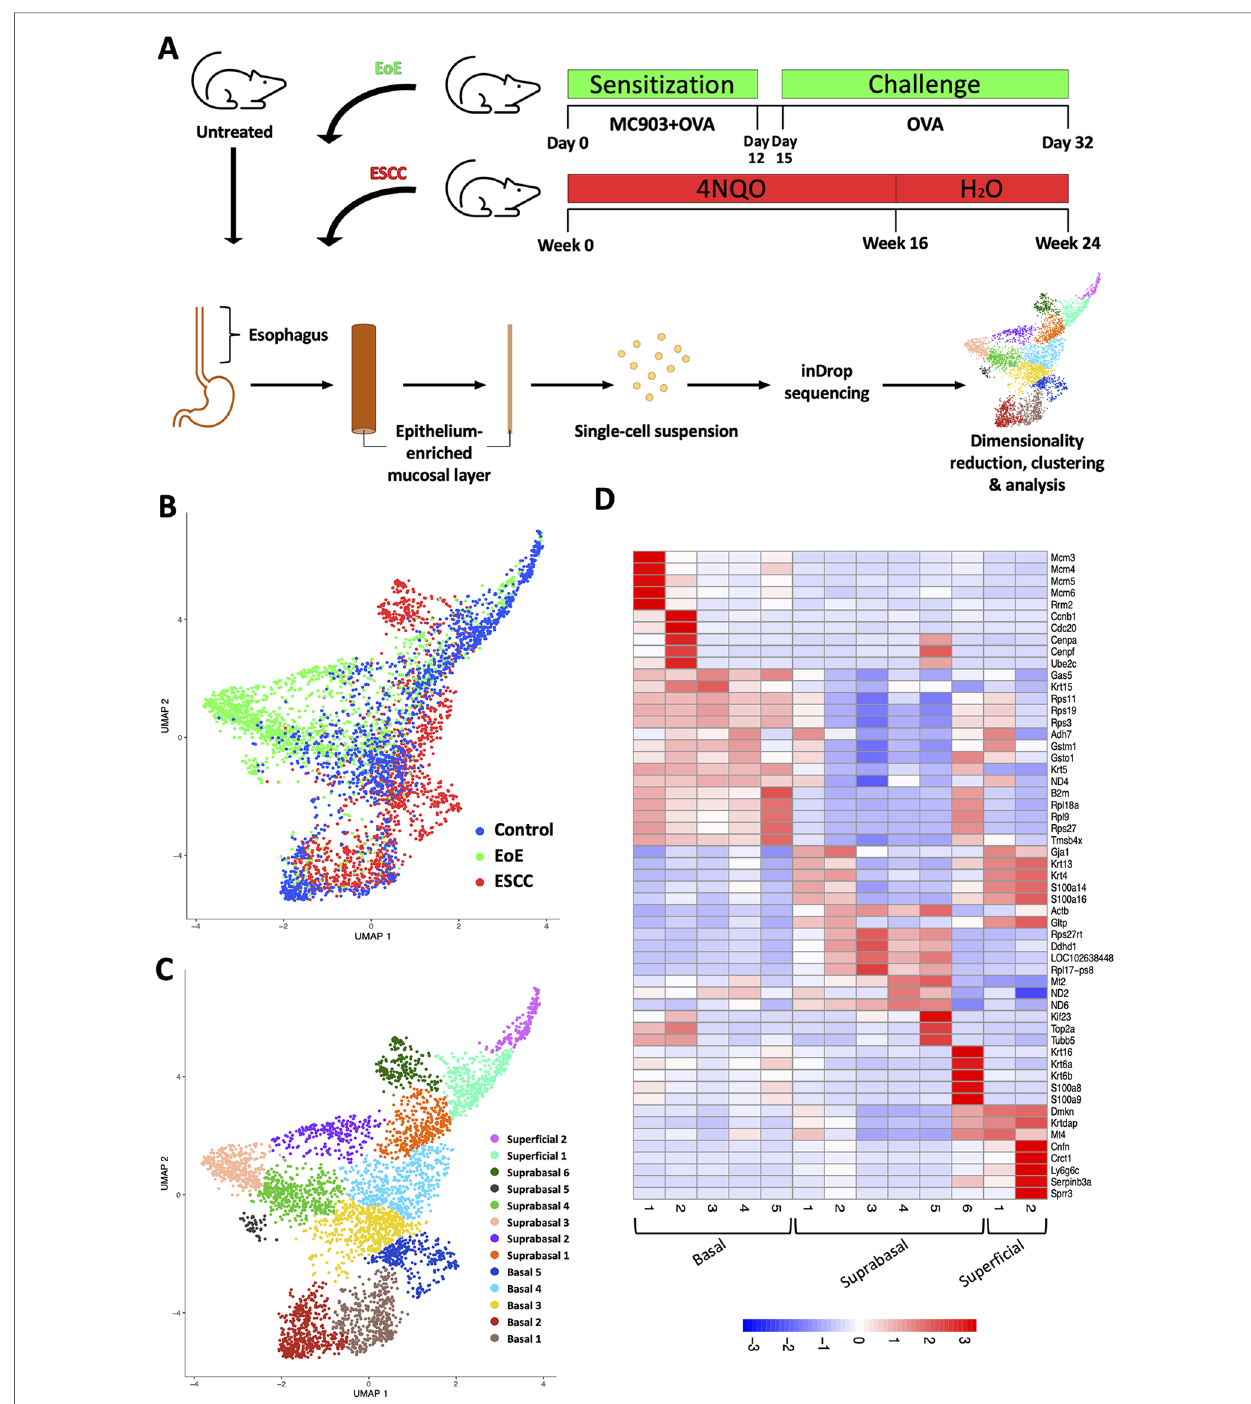
FIGURE 1 Single cell pro fi ling of esophageal epithelium from mice treated with eosinophilic esophagitis (EoE) or esophageal squamous cell carcinoma (ESCC). ( A ) Schematic of experimental approach. MC903 and Ovalbumin (OVA) were used to induce EoE over 32 days in C57B6 mice ( n =4). During the 12-day sensitization period, mice were treated epicutaneously with MC903 and OVA. Challenge with OVA in drinking water and via gavage (3x/week) was conducted from day 15 through day 32. ESCC was induced in C57B6 mice ( n =3) using the chemical carcinogen 4-nitroquinoline-1-oxide (4NQO). 4NQO was administered via drinking water for 16 weeks followed by an 8 week wash out period. Untreated C57B6 mice ( n =6) served as controls. In each mouse, esophageal epithelium-enriched mucosal layer was peeled from underlying muscle then enzymatically digested to generate a single cell suspension that was subjected to single cell RNA-Sequencing using the inDrop platform. ( B,C ) Uniform Manifold Approximation and Projection plot (UMAP) shows distribution of all cells from the single cell RNA-Sequencing dataset by condition with blue identifying cells from control mice, green identifying cells from mice with EoE, and red identifying cells from mice with ESCC in ( B ) or by distinct cell populations identi fi ed using the R-based program Monocle3 in ( C ). ( D ) Heat map shows z-score scaled normalized expression of up to 5 of the most uniquely upregulated genes in each population across all clusters. Red represents upregulation and blue represents